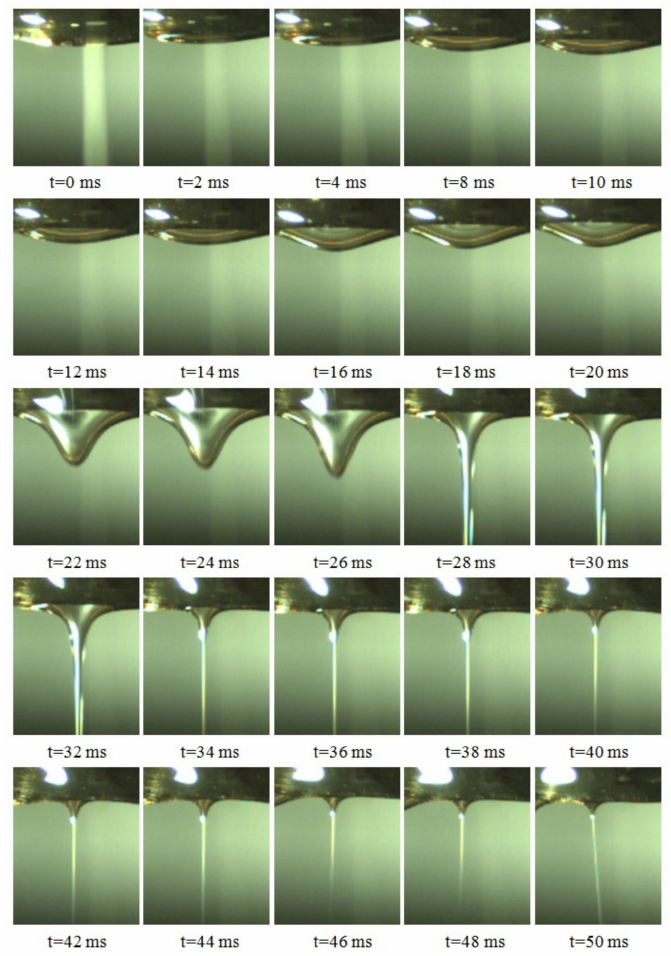
Figure 3. Photos of single jet formation